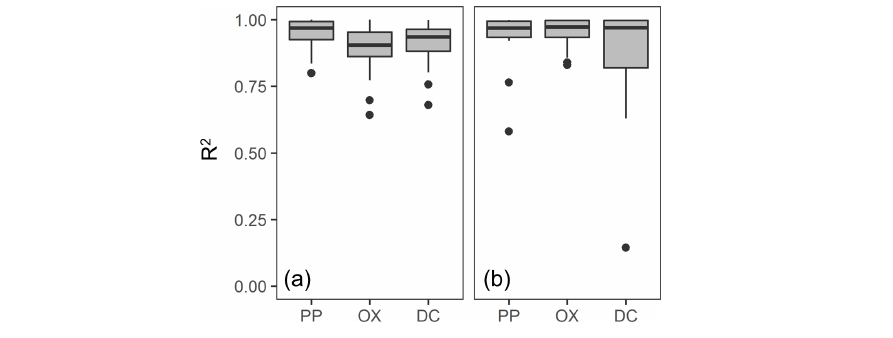
Figure A2. Boxplot of r 2 value for the normal distribution curve fitting of the extractable metal concentration (a) and distribution (b) against mean particle density. The fitting was done for each soil and each extraction as shown in Fig. A1.